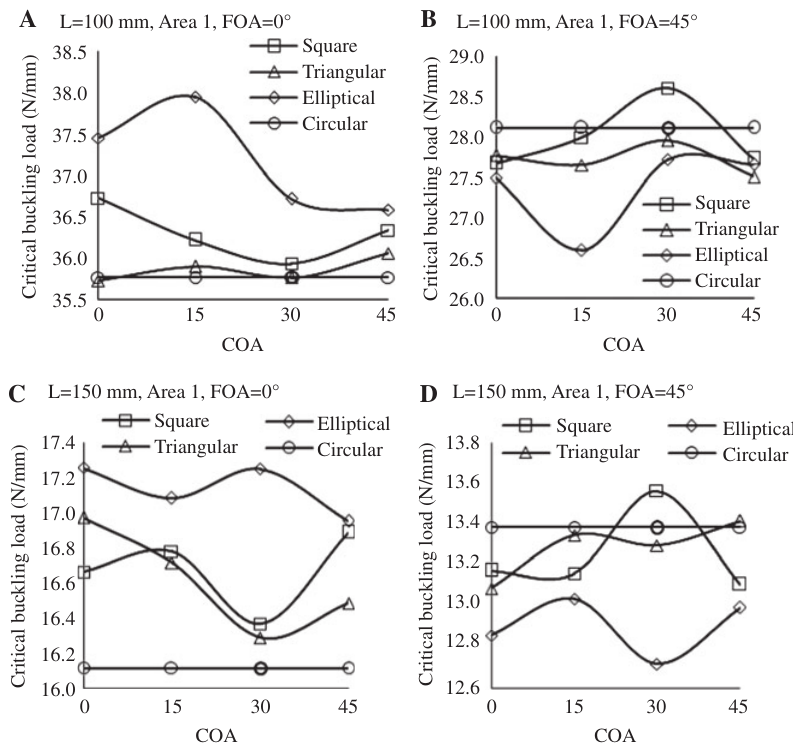
Figure 9 Effects of COA on critical buckling load (A) FOA = 0 ° , L = 100 mm, (B) FOA = 45 ° , L = 100 mm, (C) FOA = 0 ° , L = 150 mm and (D) FOA = 45 ° , L = 150